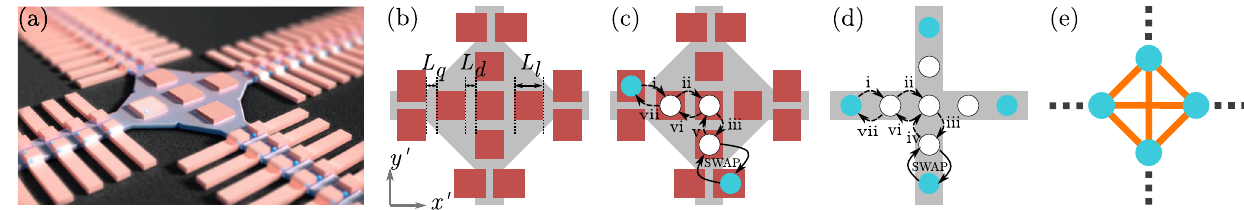
Fig. 3 Junction and shuttling sequence. a Schematic diagonal view of the junction connecting two x 0 and two y 0 submodules. b Top view of the junction. c Shuttling sequence from x 0 submodule at the left to y 0 submodule at the bottom. Arrows indicate three consecutive spin shuttling operations (i – iii), followed by a SWAP operation, and another three consecutive spin shuttling operations (v – vii). d Same as c , abstracted. e Hardware topology of the junction. Qubits (dots) of x 0 and y 0 submodules are connected via six shuttling and one SWAP operations